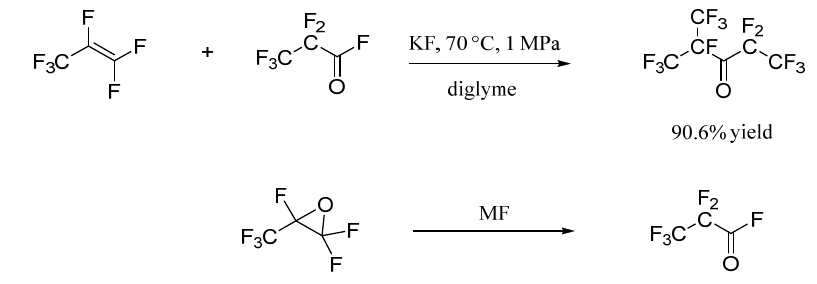
Figure 4. Three main synthesis routes for C 6 F 12 O.